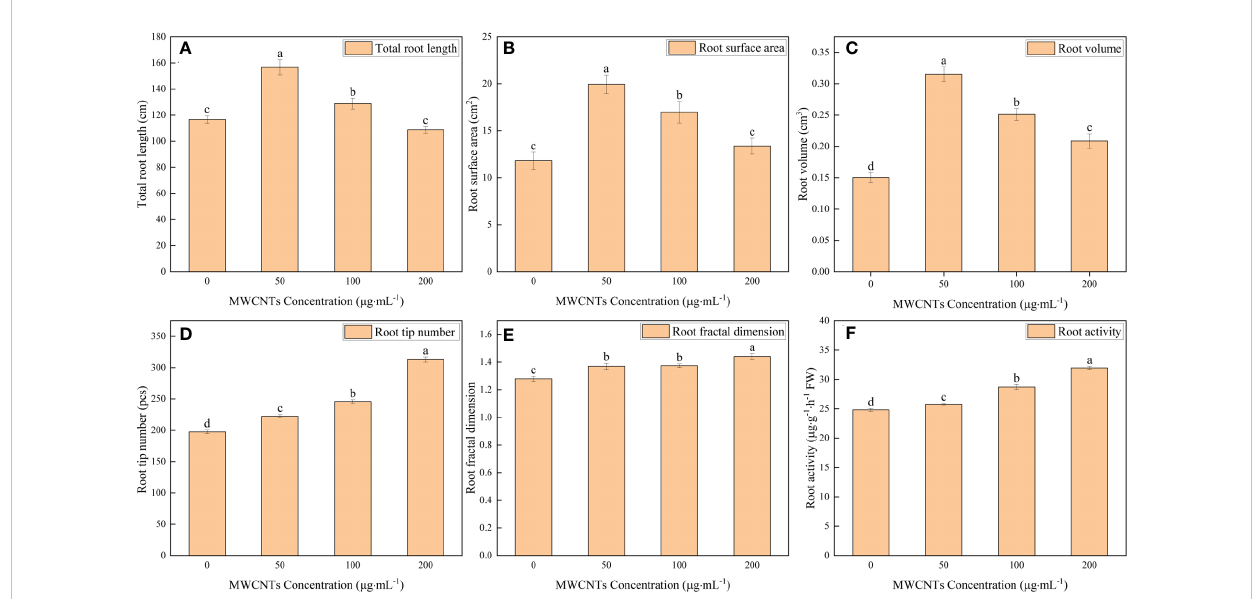
FIGURE 2 Total root length (A) , root surface area (B) , root volume (C) , root tip number (D) , root fractal dimension (E) , and root activity (F) of Malus hupehensis seedlings under the 0, 50, 100, and 200 µg·mL -1 MWCNTs treatments for 30 days. Different lowercase letters indicate signi fi cant difference at P < 0.05, and error bars represent the standard deviation of the mean (One-way ANOVA,